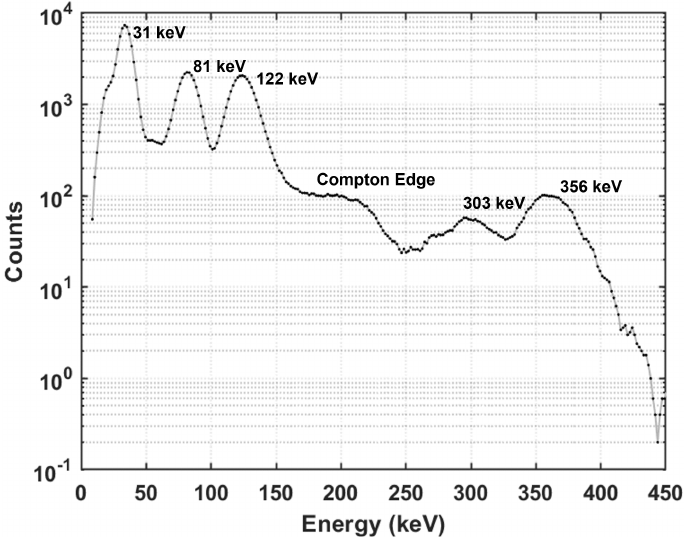
Figure 7. Gamma-ray spectrum resulting by the ROI selection.